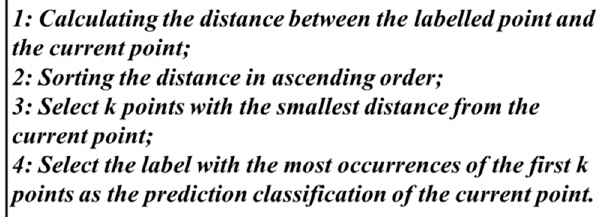
Figure 9. The k-nearest neighbors